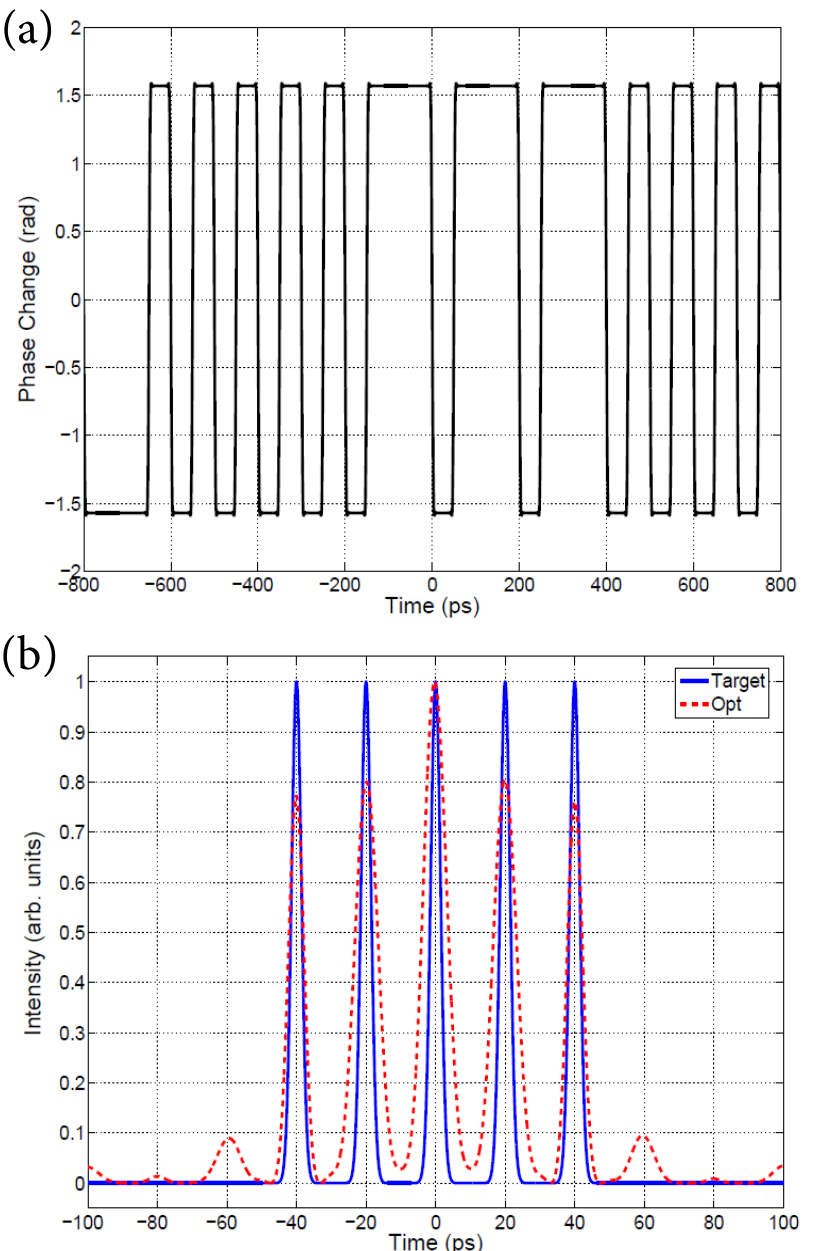
Figure 9. Genetic Algorithm method. (a) Optimal binary phase modulation code. (b) Target and optimized temporal intensity